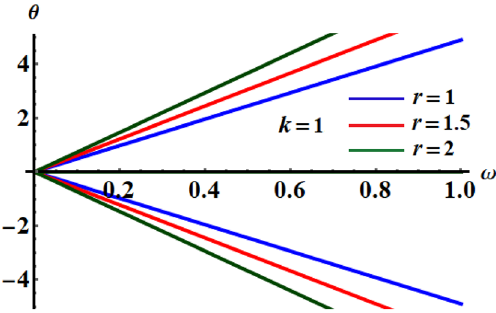
Figure 5. Describes the variety of θ versus ω at r = 1, 1.5 and 2 .